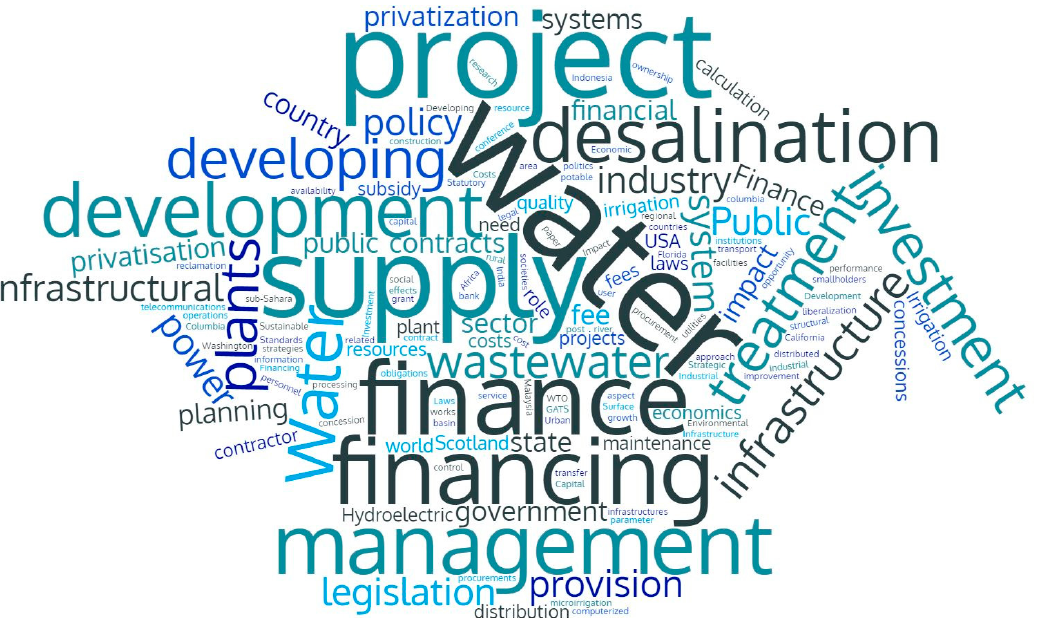
Figure A3. Research topics’ word cloud—1990s.